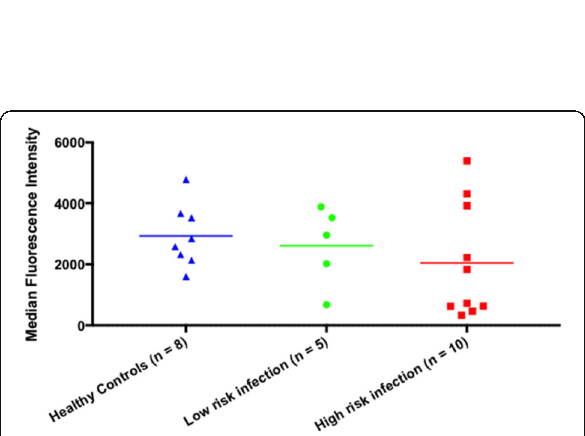
Fig. 3 (abstract P49). Total cellular ROS as measured by DCFDA with flow cytometry analysis (p = 0.4038, Kruskal-Wallis test). Fewer number of samples in low risk infection group was due to inadequate cell number. Apoptosis, a common sequela of reduced mitochondrial function, did not differ between groups; however, the high-risk group did show some signs of early apoptosis (Fig. 4).